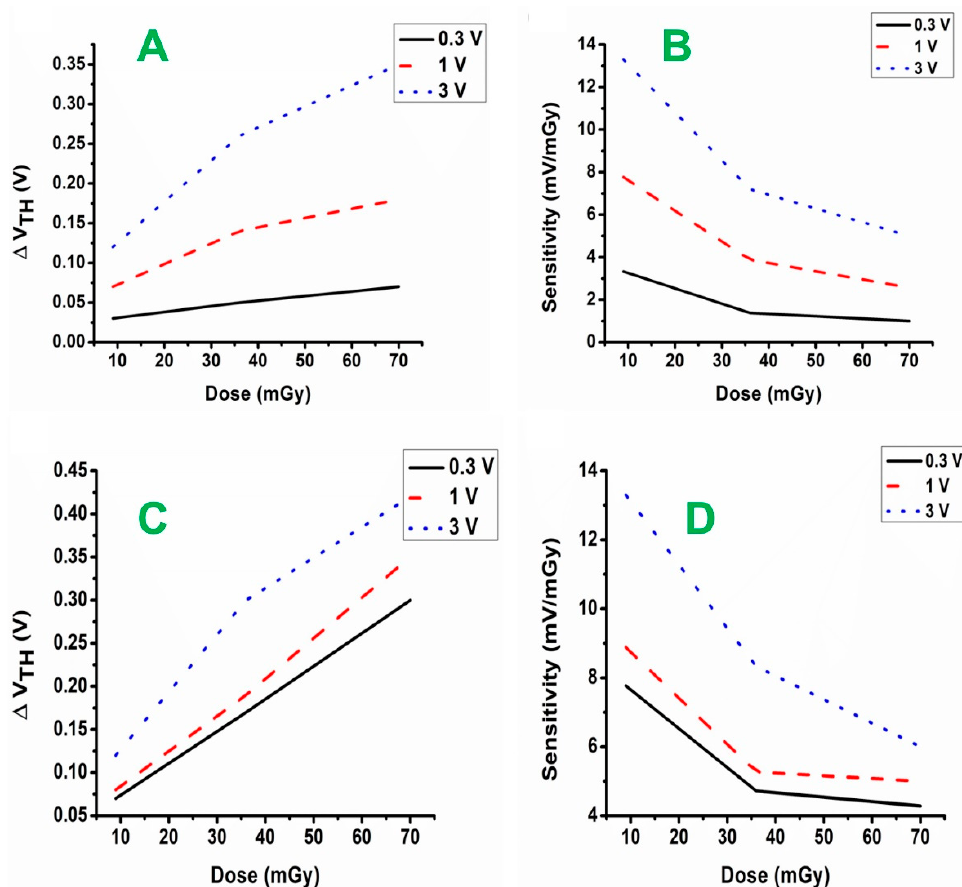
Figure 9. The effect of bias voltage on ( A , C ) threshold voltage with dose and ( B , D ) sensitivity with dose for thick film and disk type AZO, respectively.